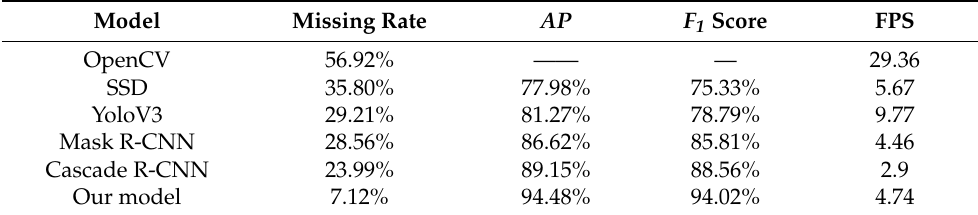
Table 5. Performance comparison of different models for netting damage